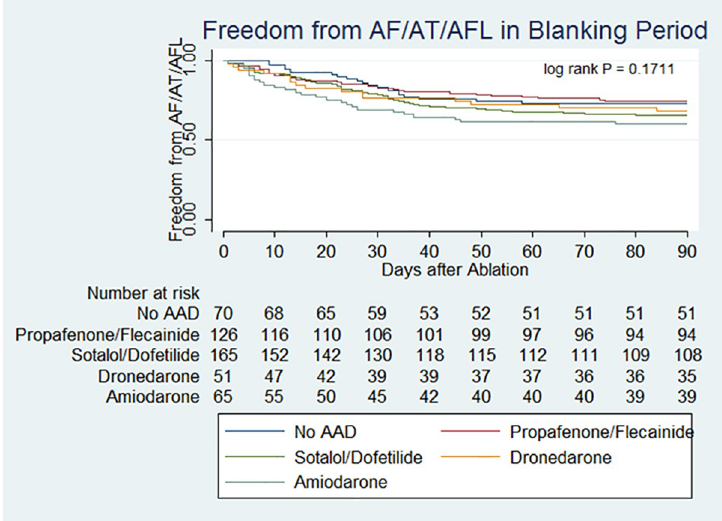
Fig 1. Kaplan-Meier plot of freedom from AF/AT/AFL in 3-month blanking period after ablation.